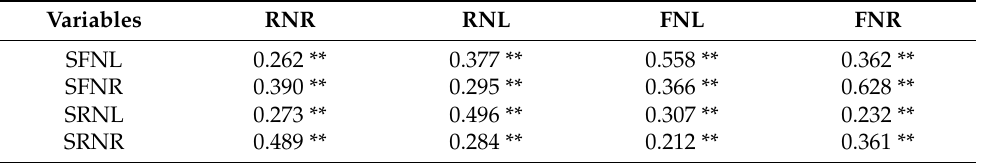
Table 4. Association between willingness to share and belief in (fake) news. Variables